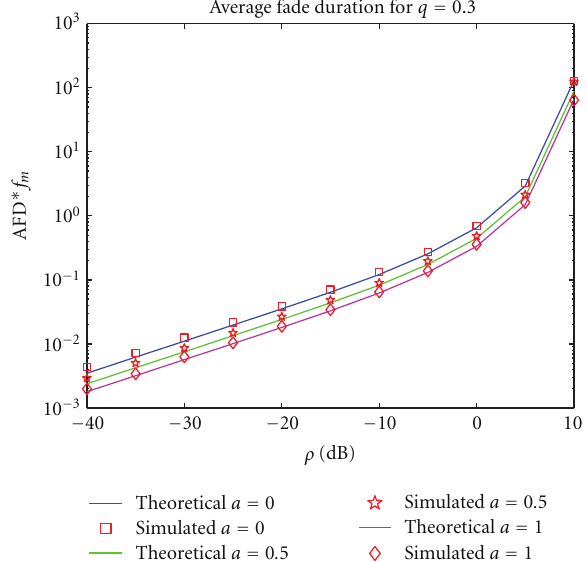
Figure 15: Average duration of fade for q = 0 . 3, k = 3.